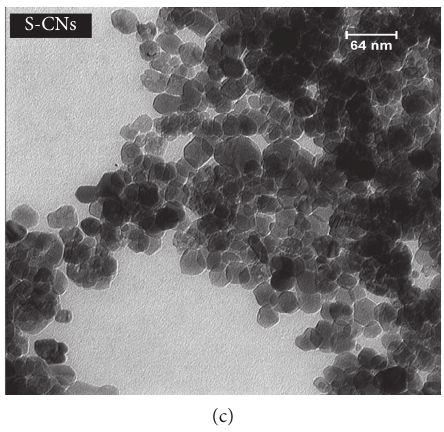
Figure 4: TEM images of (a) CNs, (b) N-CNs, and (c)